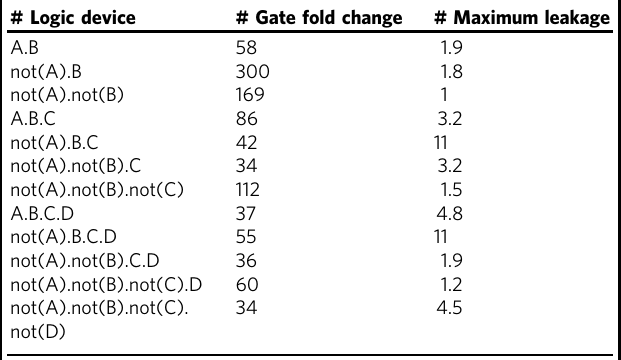
Table1 Recombinase device characteristics # Logic device